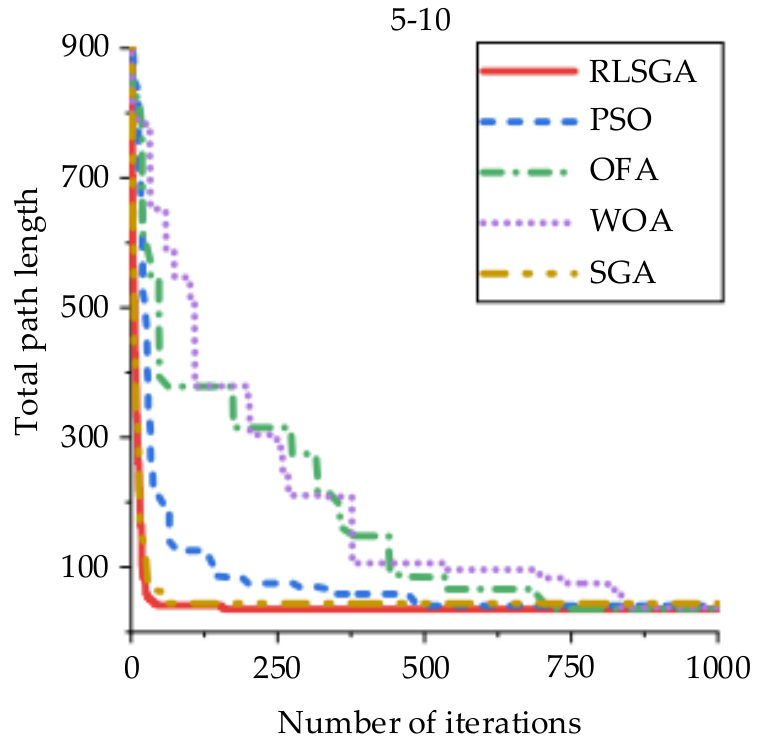
Figure 10. Comparison of rack travel distance between considering equilibrium and not considering.